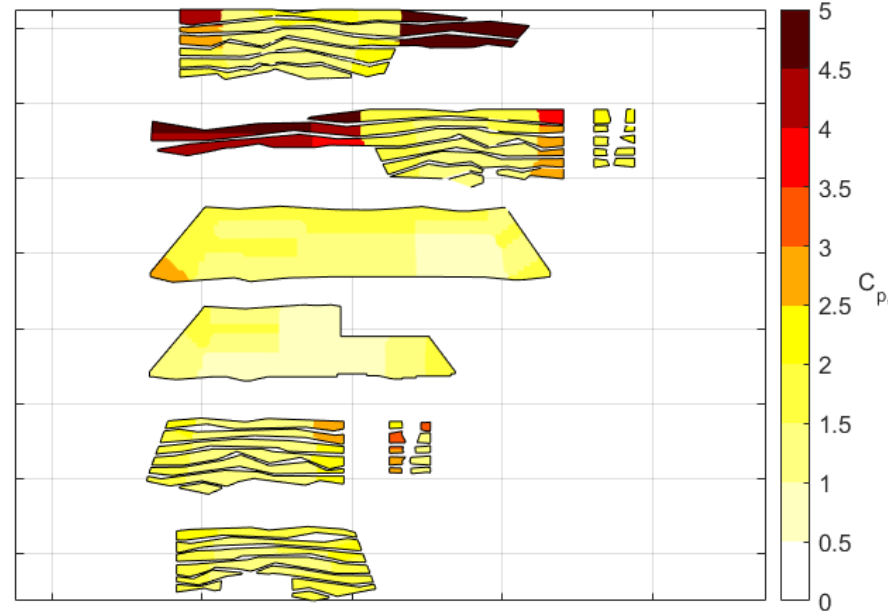
Figure 19. Envelope maps of the positive ˆ C p , net , measured on the porous façade of the PDSF.